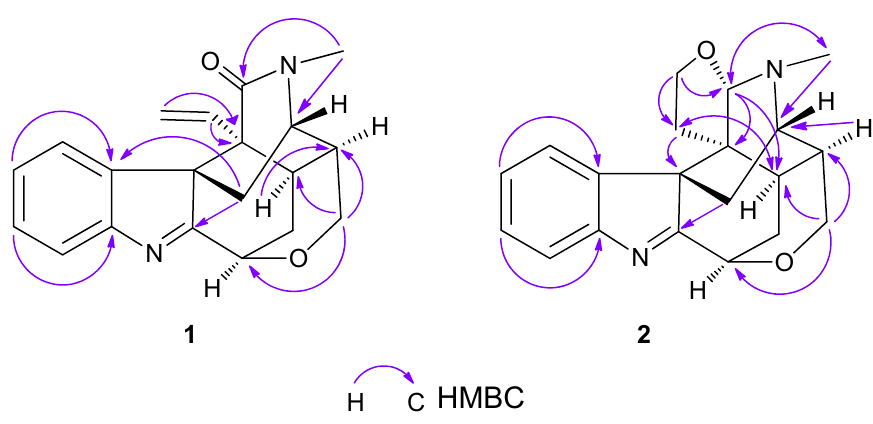
Figure 2. Key HMBC correlations of 1 and 2